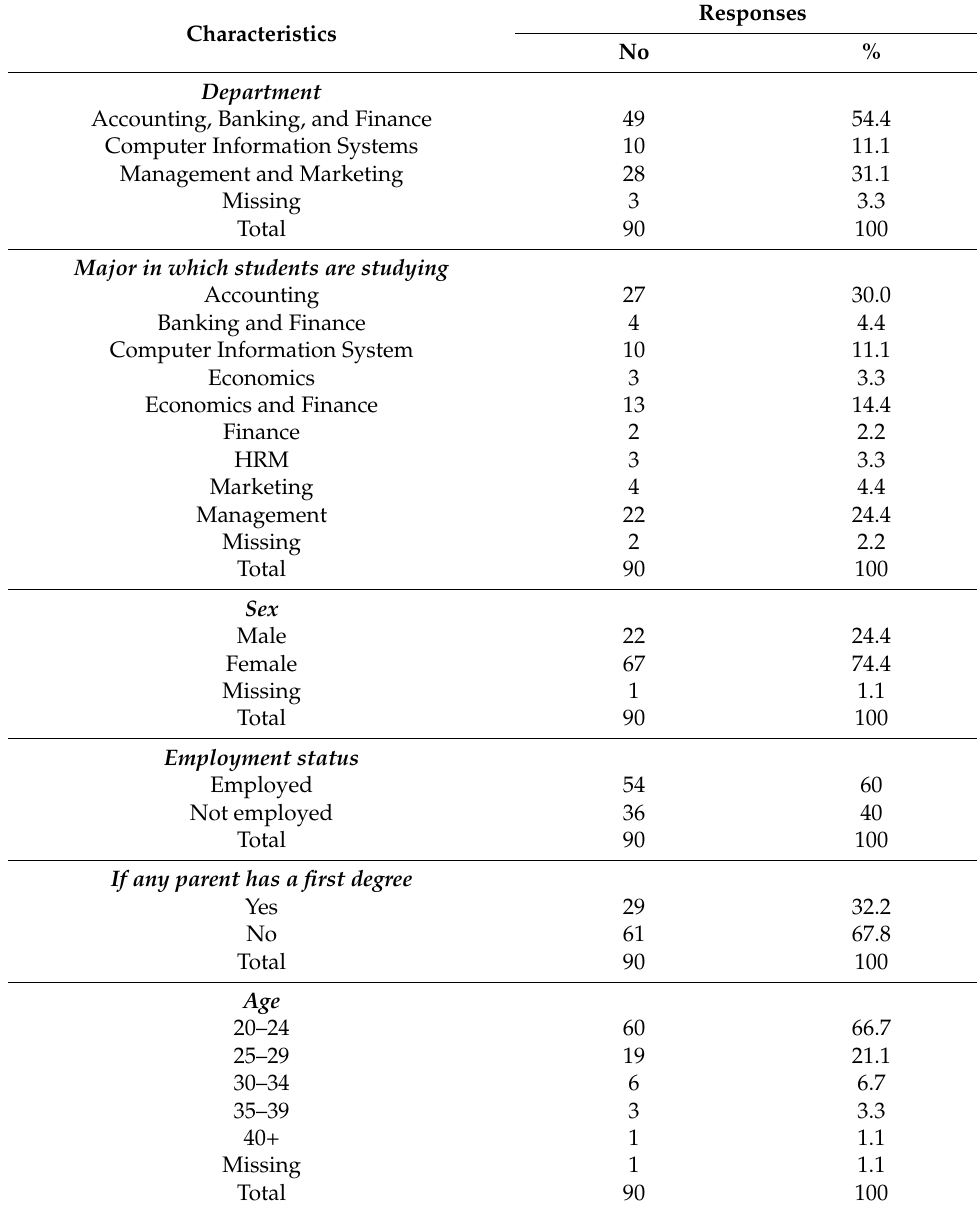
Table 1. Demographic